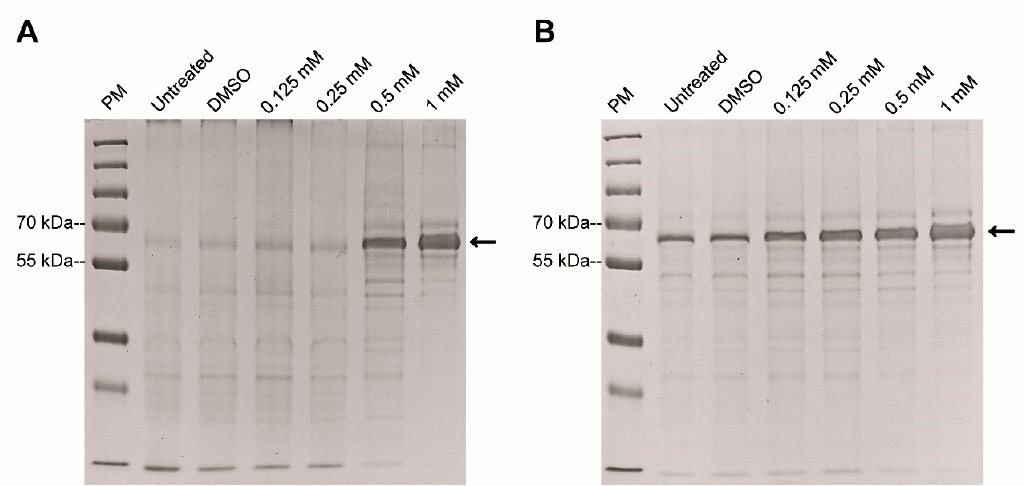
Figure 4. Effect of ASA on electrophoretic protein pattern of Giardia lamblia . Trophozoites exposed for 24 h ( A ) and 48 h ( B ). PM, ladder protein marker.